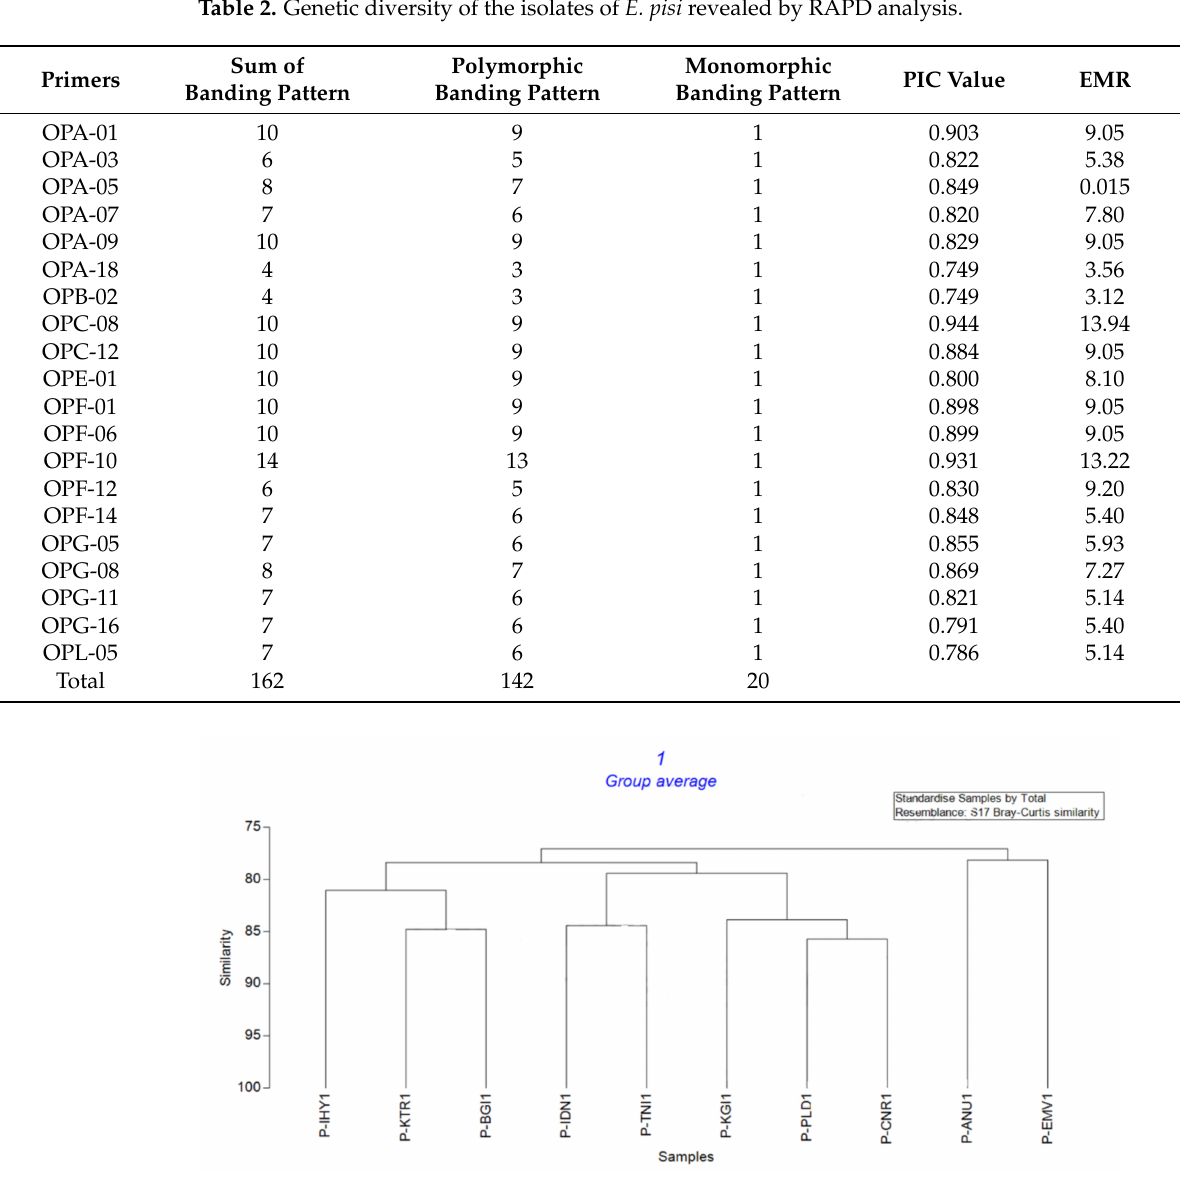
Figure 5. UPGMA cluster analysis of E. pisi based on RAPD primers. (P-IHY1—Iduhatty,